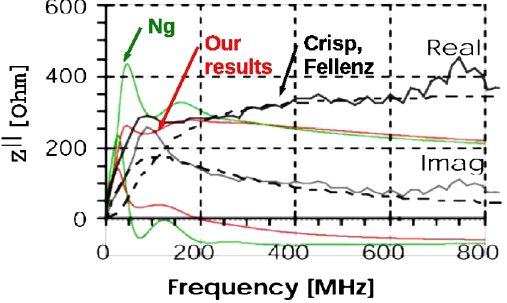
FIG. 8. Longitudinal impedance in the Booster F-magnet. The black and gray lines show the measurements of Crisp and Fellenz [1] (real and, respectively, imaginary impedance). The black dashed lines represent a fitting model of a resistor in parallel with an impedance. The green line are the calculations of Ng [7]. Our calculations are shown with red